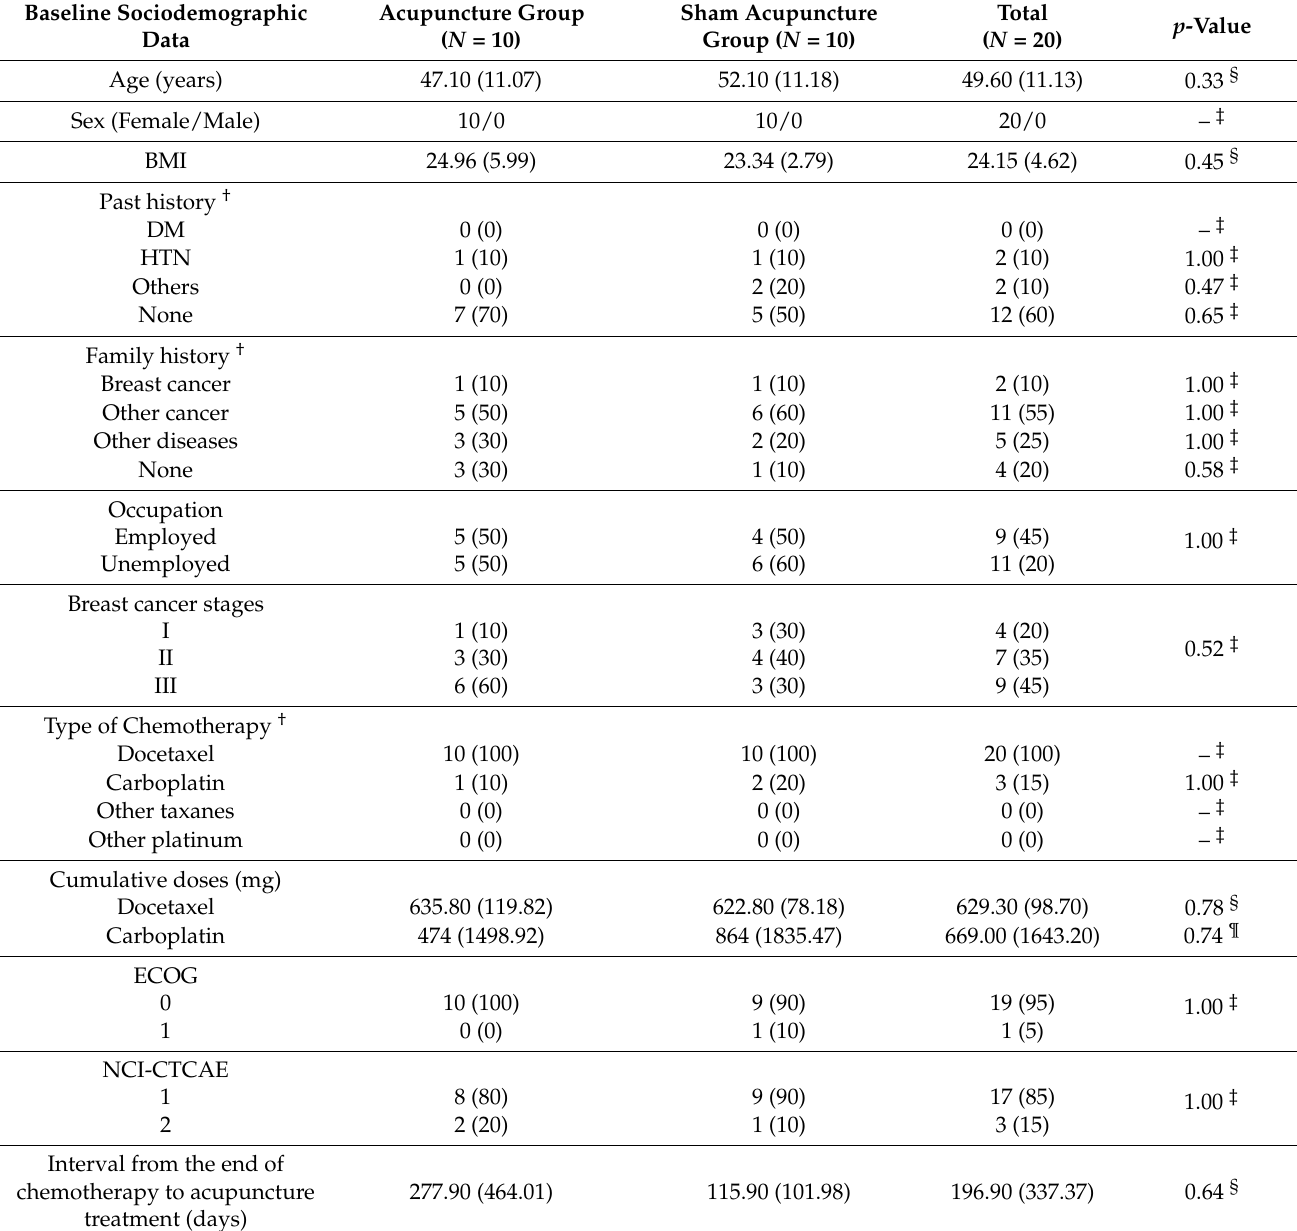
Table 1. Baseline sociodemographic data of eligible